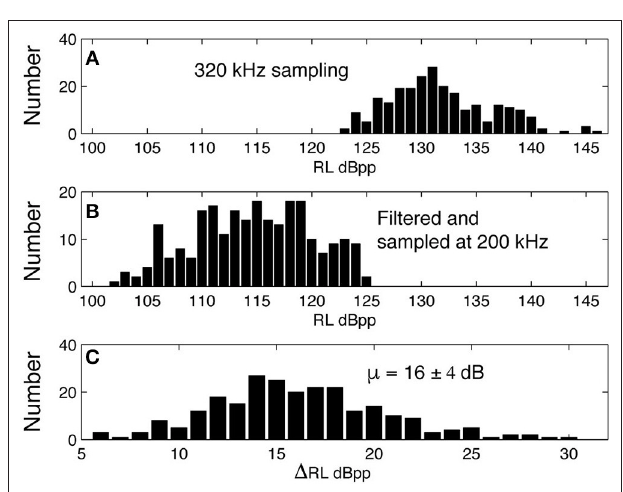
FIGURE 5 | Peak-peak received level for clicks recorded at 320kHz sampling rate (A) are filtered with the HARP system transfer function and resampled at 200kHz (B) , yielding a mean difference of 16 dB between the peak-to-peak received signal levels (C)